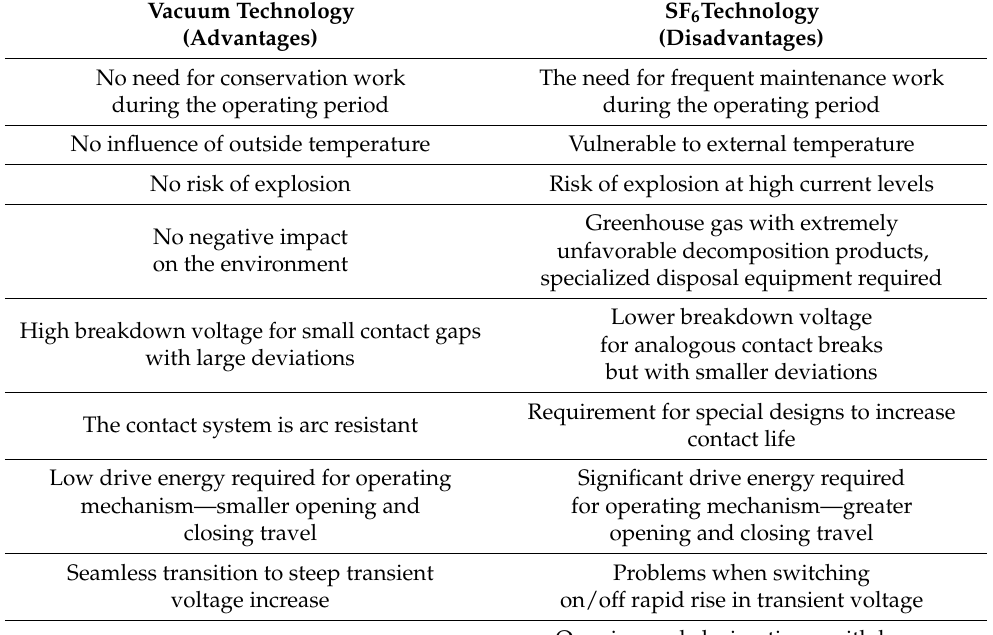
Table 2. Overview of the properties of vacuum-insulated and SF 6 -insulated equipment